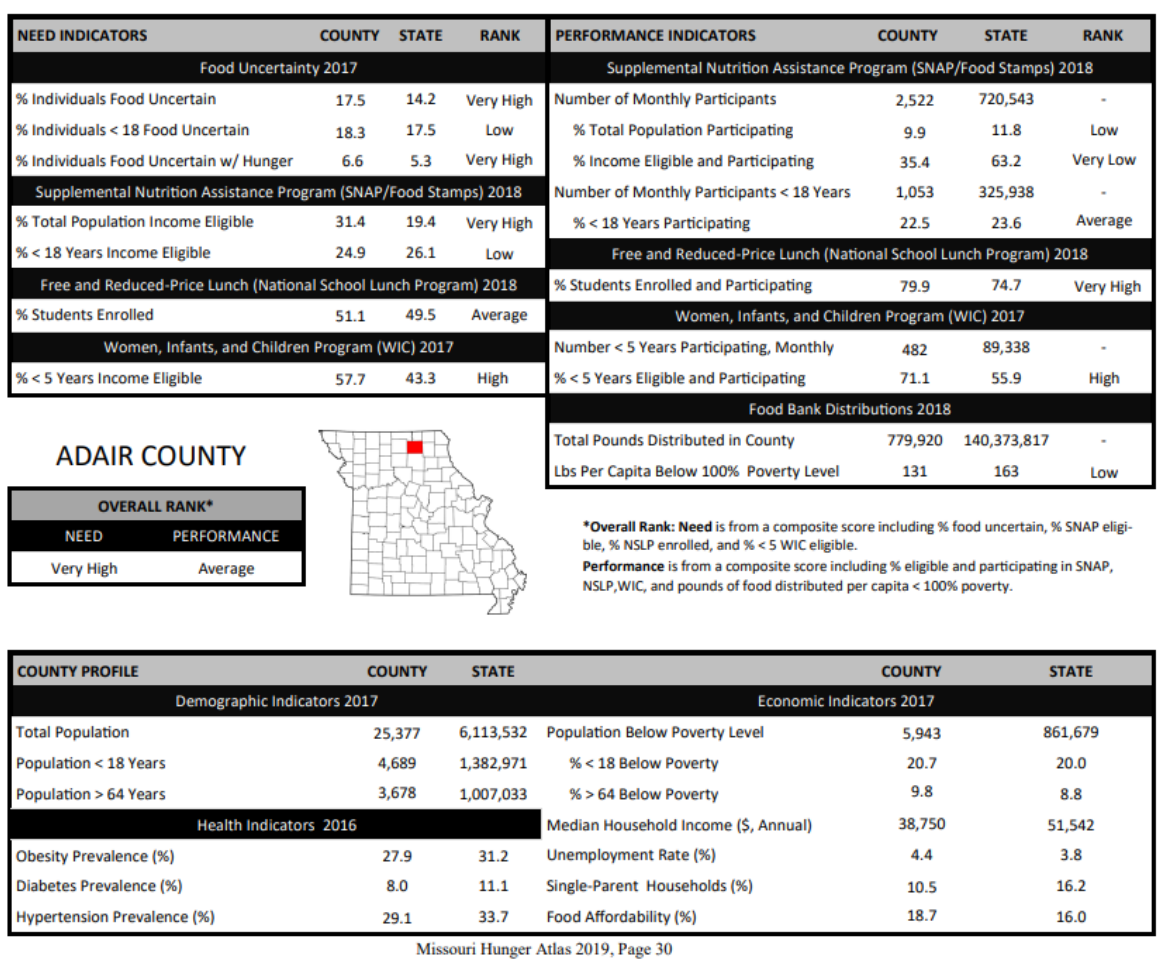
Figure 3. County Data